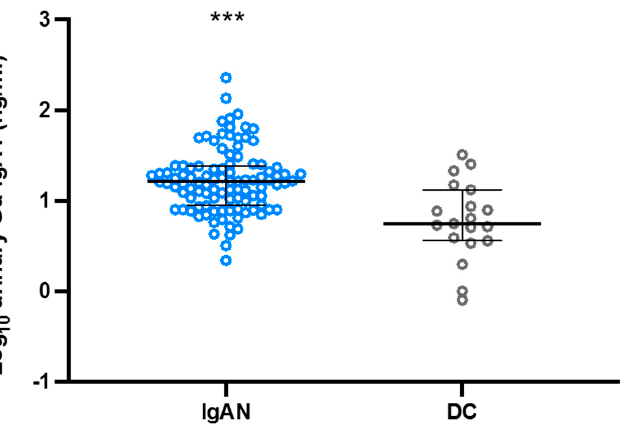
Figure 4. Urinary Gd-IgA1 excretion in cases with trace amounts of proteinuria (less than 0.3 g/gCr). *** p < 0.0001. *** p <